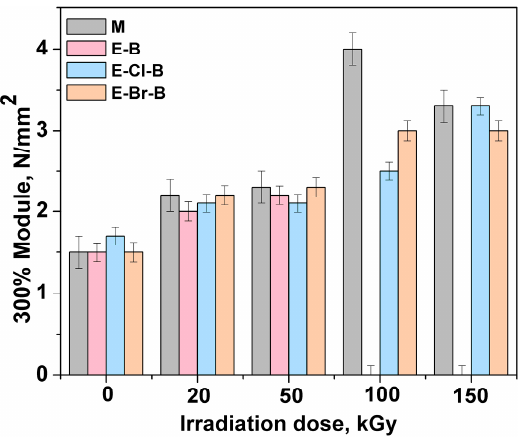
Figure 3. Variation of 100% modulus with electron beam irradiation dose.